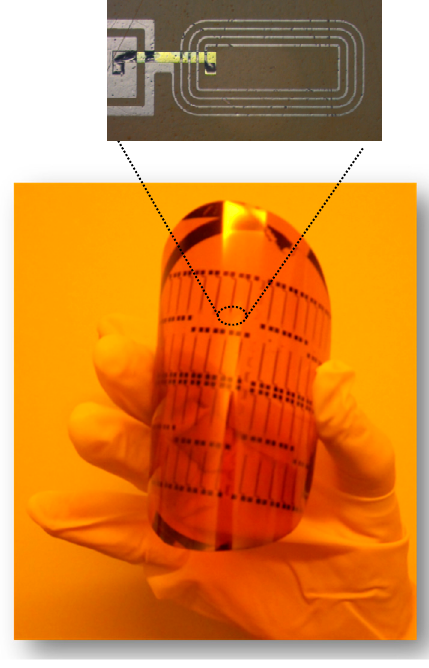
Figure 5. Microcoils on kapton